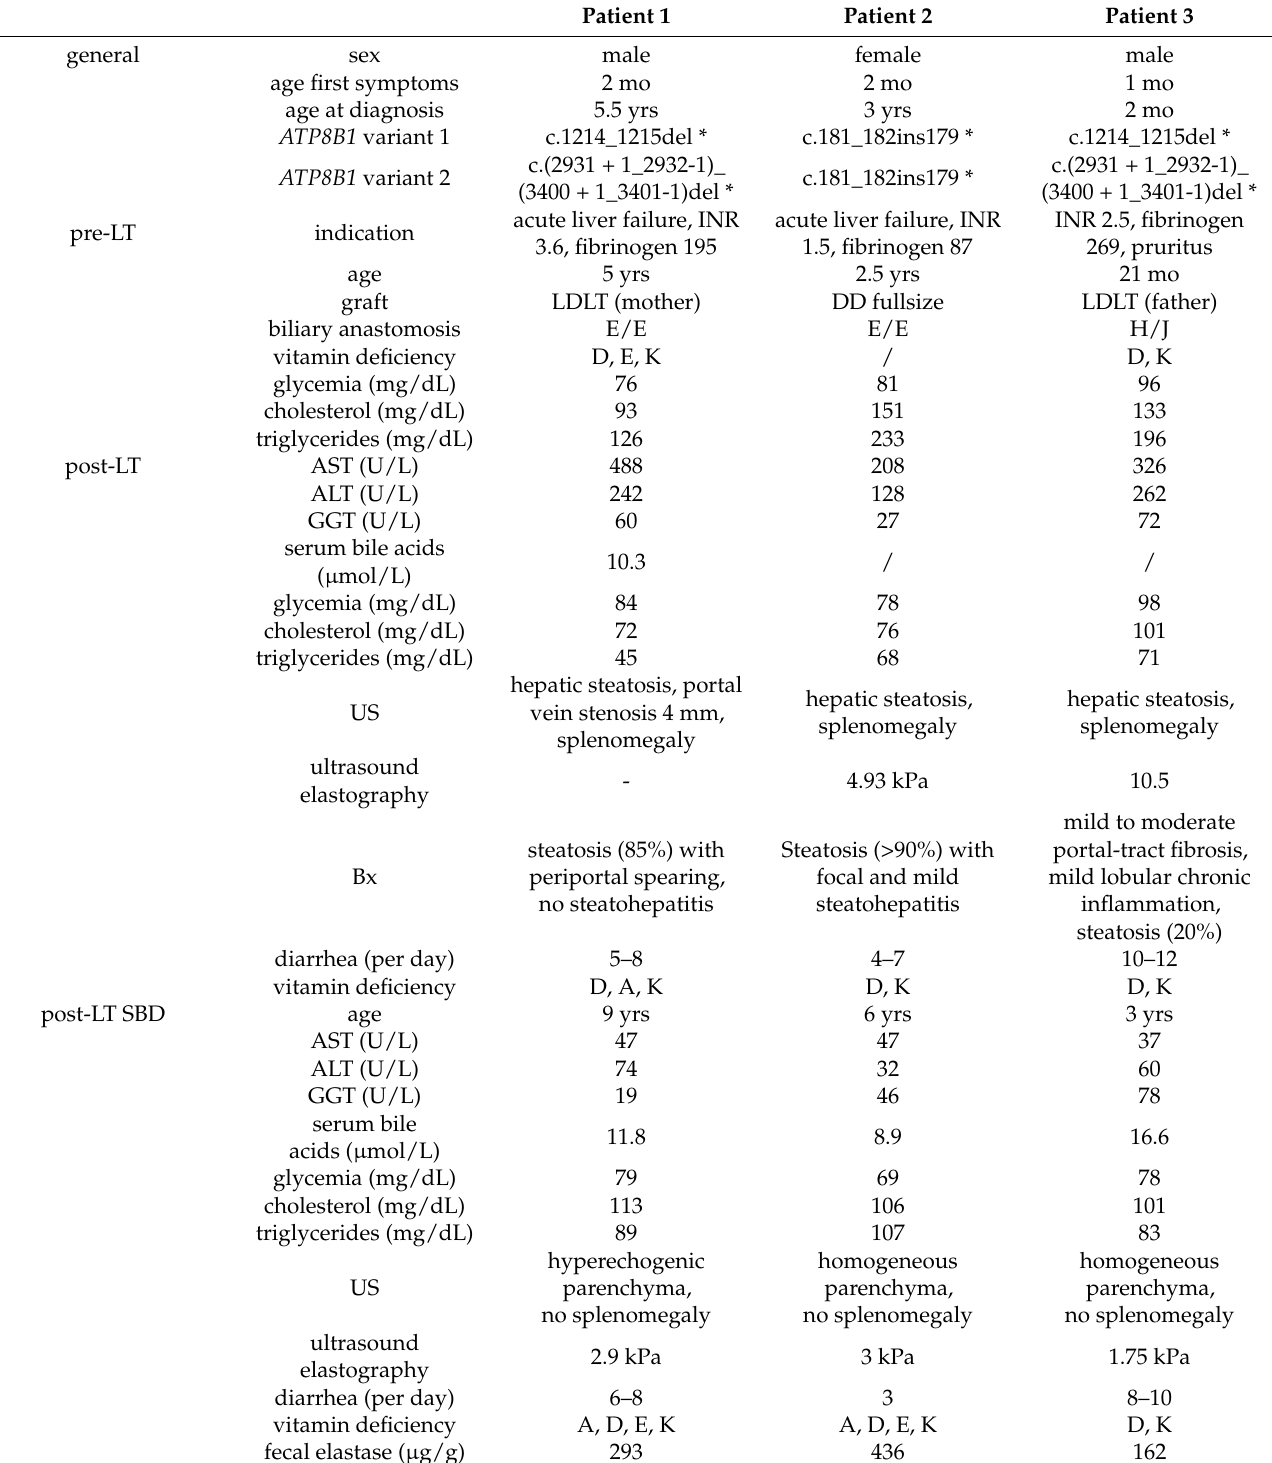
Table 1. Clinical and genetic findings in PFIC1 patients. Patient